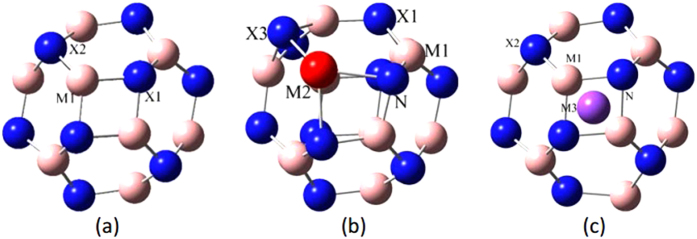
Geometry sketches.(a) MX clusters (M1 = B, Al, Be, Mg; X = N, P or O); (b) AlB11N12 and GaB11N12 (M2 = Al, Ga); (c) LiB12N12 and NaB12N12 (M3 = Li, Na).